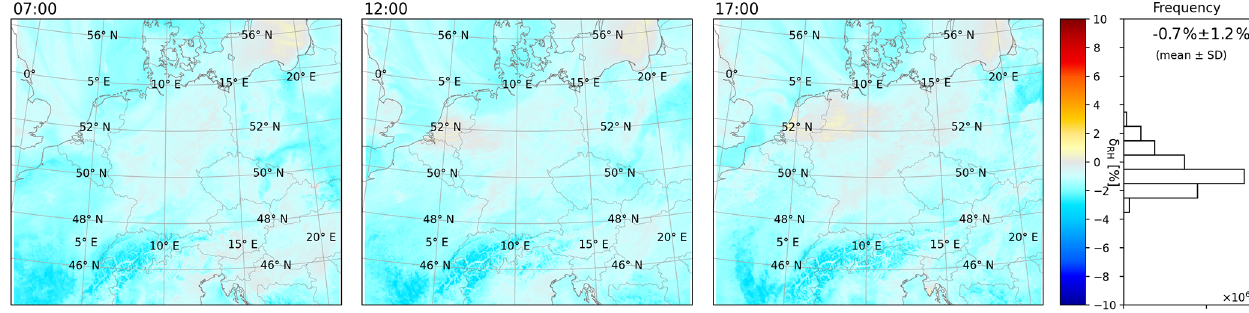
Figure 6. Deviation δ RH according to Eq. (19) for WRF simulations at 07:00, 12:00, and 17:00UTC on 1 May 2018. On the right, the frequency distribution and mean and SD are given for the WRF simulation period from May to